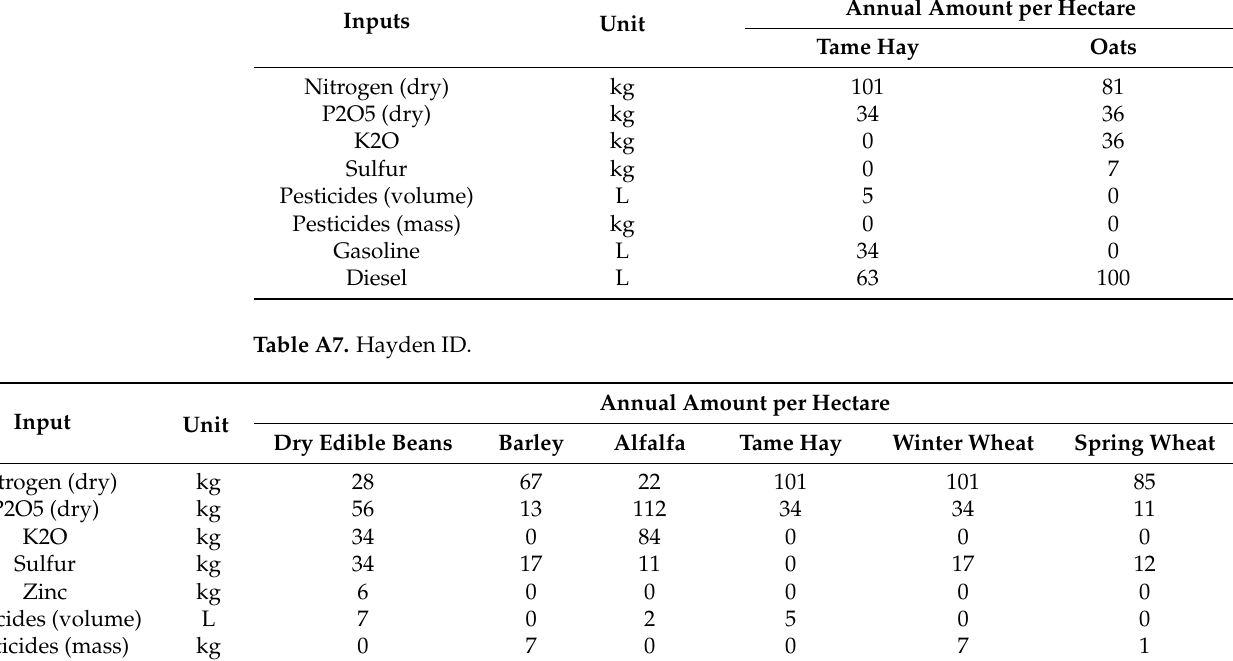
Table A6. Jefferson OR.